Question: Based on the figure, does the quantity rise or fall?
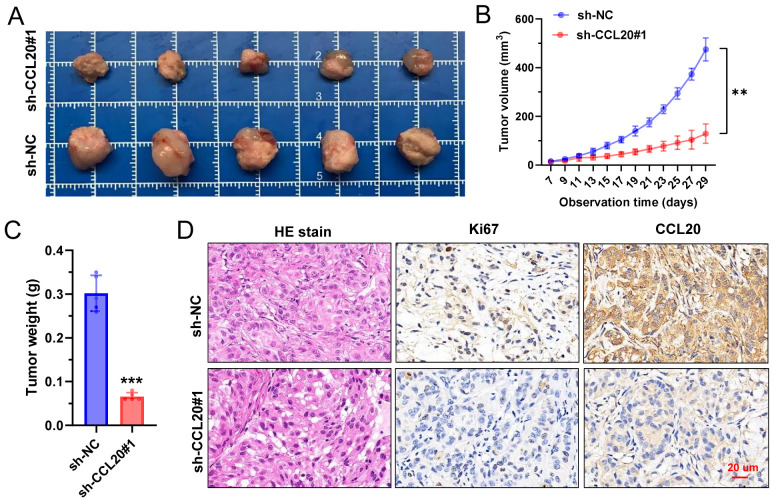
Answer: increasing